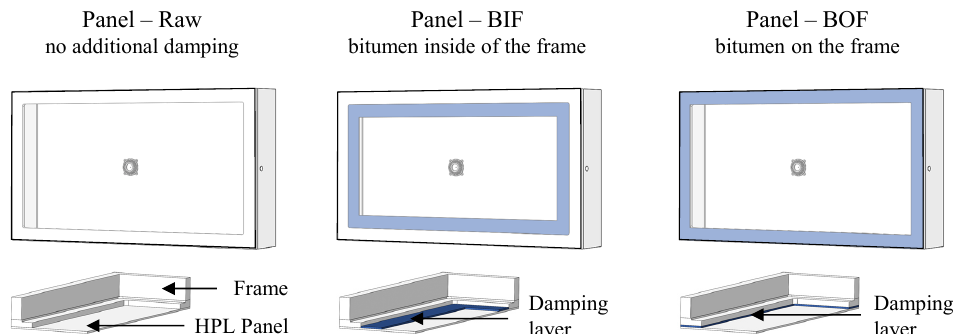
Figure 11. Front and cross-sectional view of all three variants: Panel-Raw, Panel-BIF and Panel-BOF.